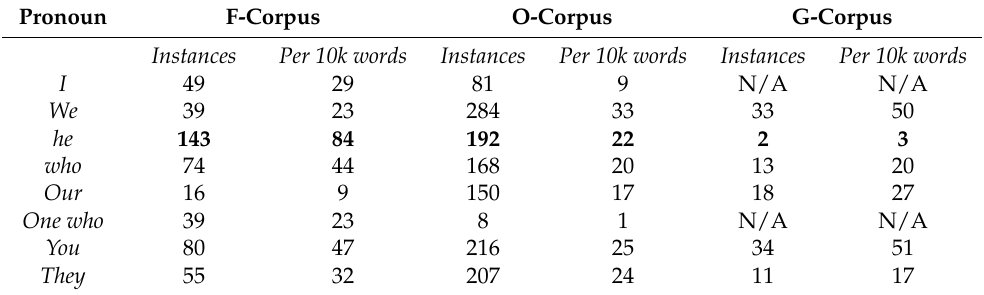
Table 5. Occurrences of pronouns in the FOG corpus.